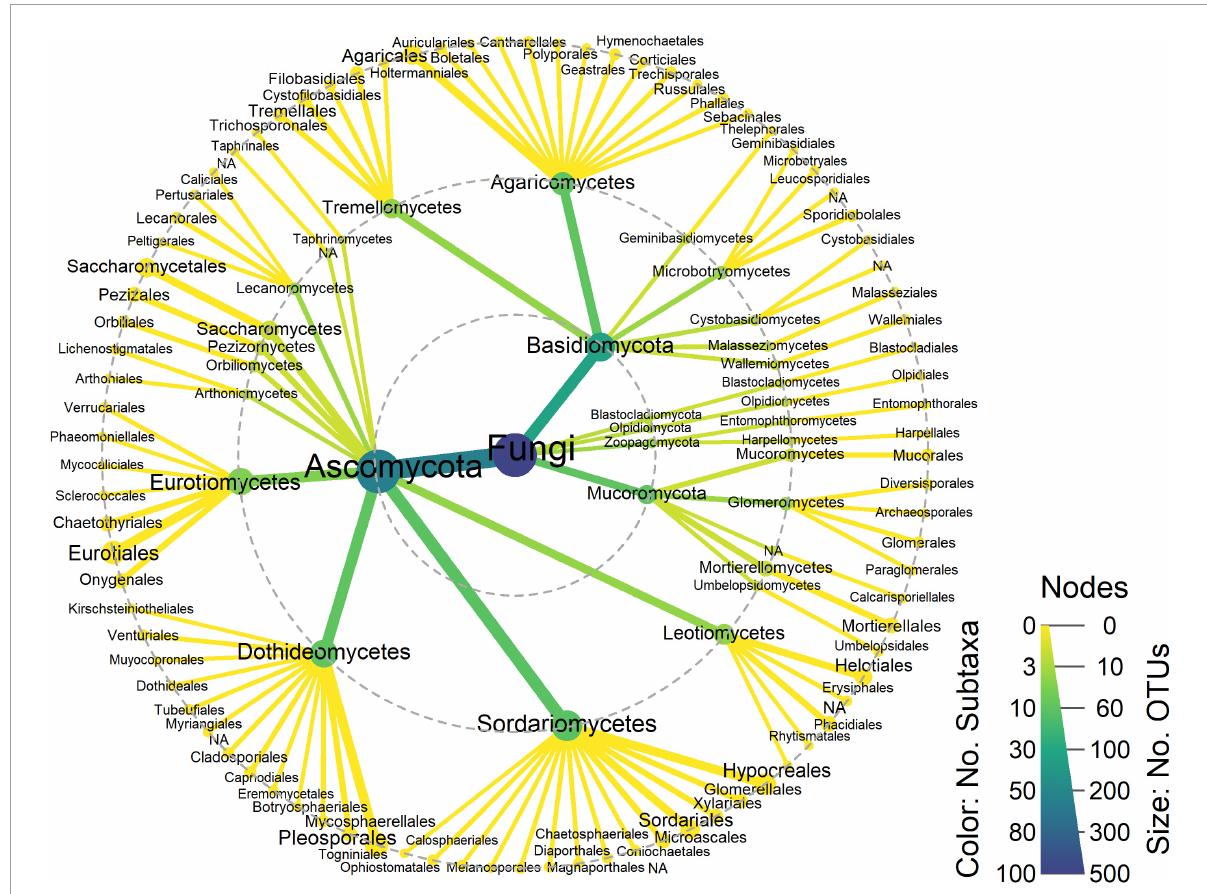
FIGURE3 Taxonomic heat tree. Node size represents the number of OTUs and color scale represents the number of subtaxa. Dashed gray circles indicate the following taxonomic levels: phylum (inner), class (middle), order (outer). NA, not assigned.